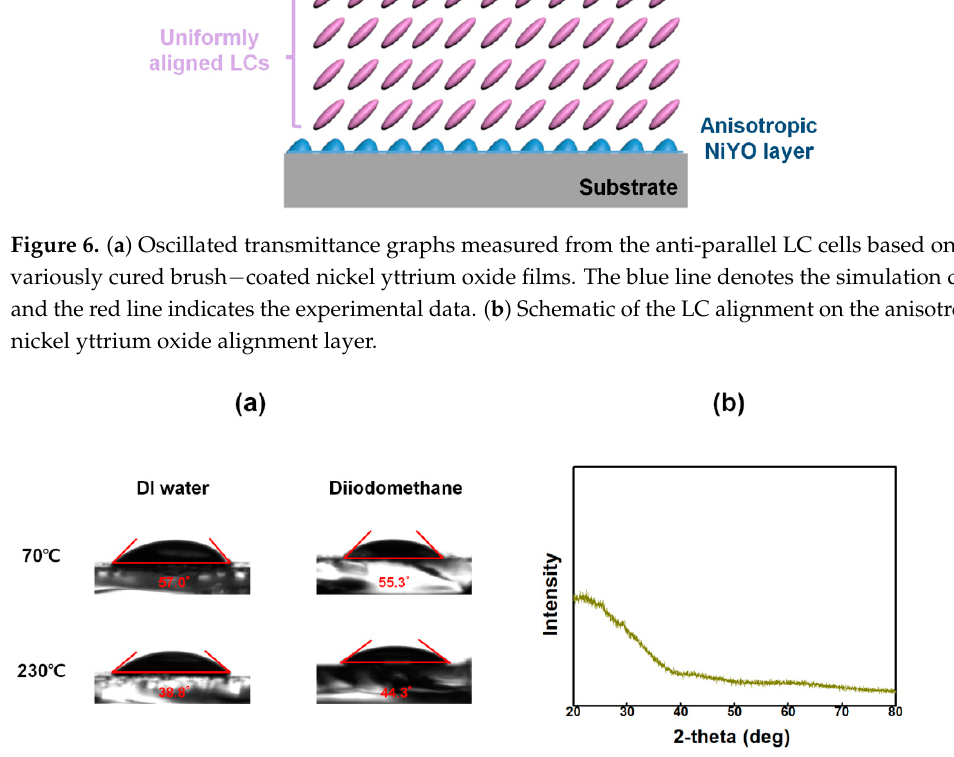
Figure 7. ( a ) Contact angle measurement results of the brush-coated nickel yttrium oxide films cured at 70 and 230 °C using deionized (DI) water and diiodomethane. ( b ) X-ray diffraction graph of the brush-coated nickel yttrium oxide film cured at 230 °C. Table 1. Contact angles and surface energies of the brush-coated nickel yttrium oxide films cured at 70 and 230 °C.